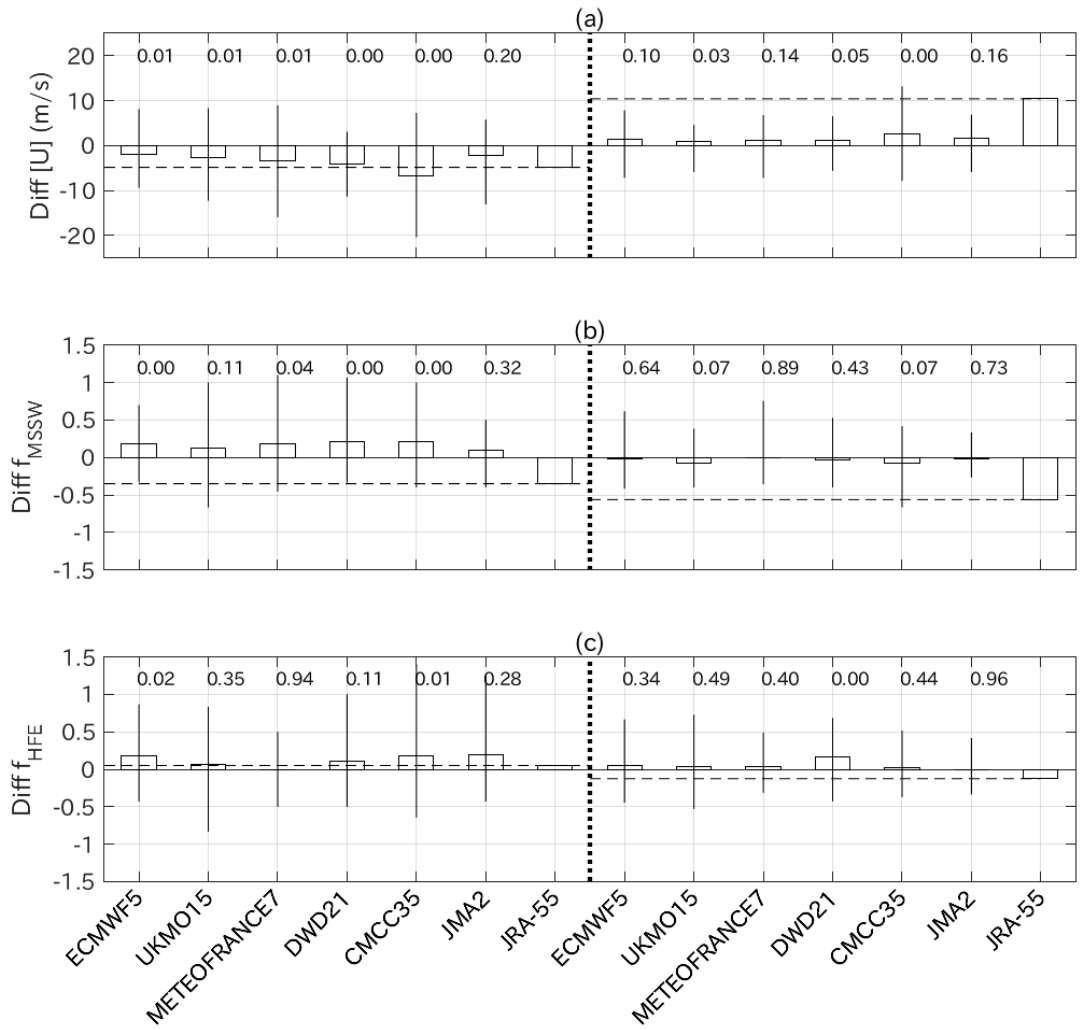
Figure 12. Bar charts showing differences of the three quantities as in Figure 7: ( a ) mean VS, ( b ) MSSW frequency, and ( c ) HFE frequency. Seven left bars in each panel plot EL minus LA, and the others plot WLY minus ELY. Number for each bar denotes the p value from the t -test (two side test) applied to the differences of the ensemble members.